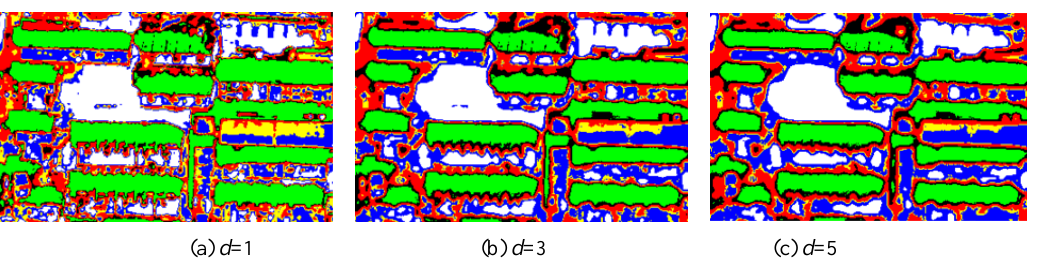
Figure 8. Results of FCM clustering segmentation employing both spectral features and spatial autocorrelation features in site 2 when window width (2 d +1) is less than the maximum